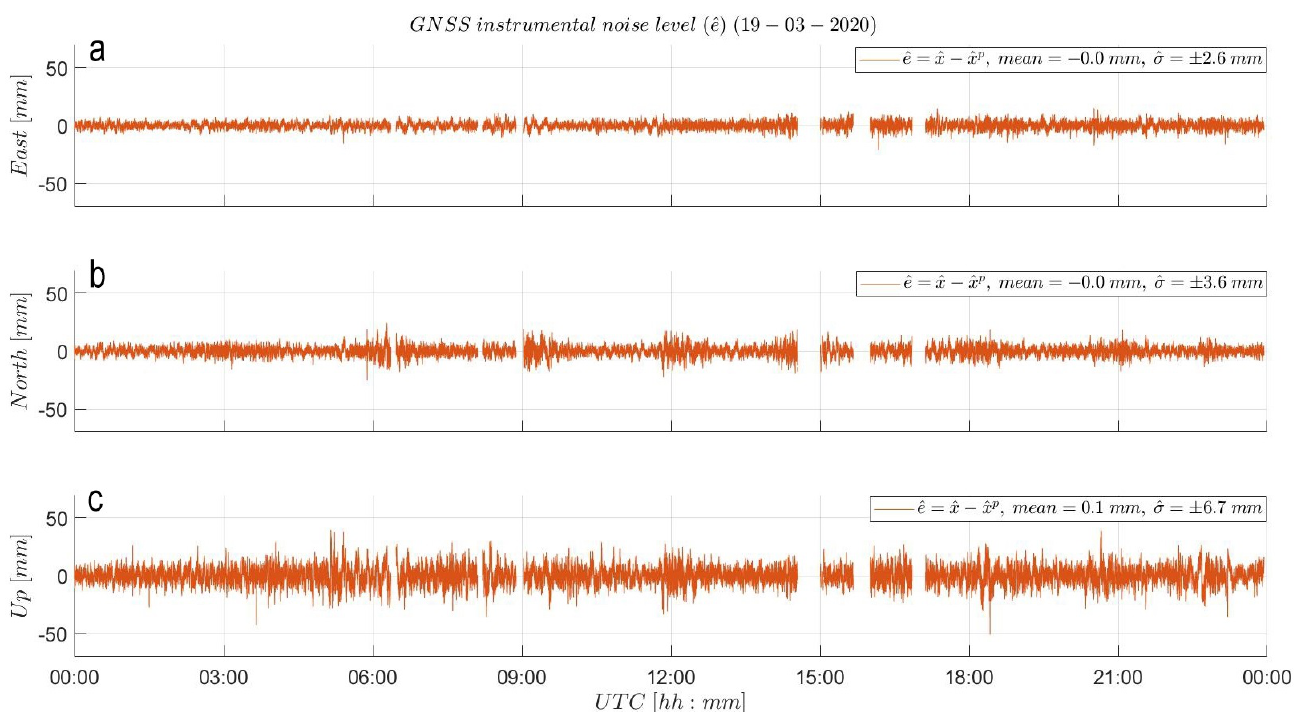
Figure 7. GNSS empirical noise (ˆ e ) analysis: ( a ) East, ( b ) North and ( c ) Up noise level of the baseline time series after LS polynomial subtraction. Resulting ENU instrumental noise time series show variabilities (ˆ σ ˆ e ) of ± 2.6, 3.6 and 6.7 mm, respectively. The gaps in data correspond to filtered out samples derived from float baseline solutions (rather than solutions with fixed ambiguity). Note the sidereal period of the time scale on the horizontal axis. The start and end point